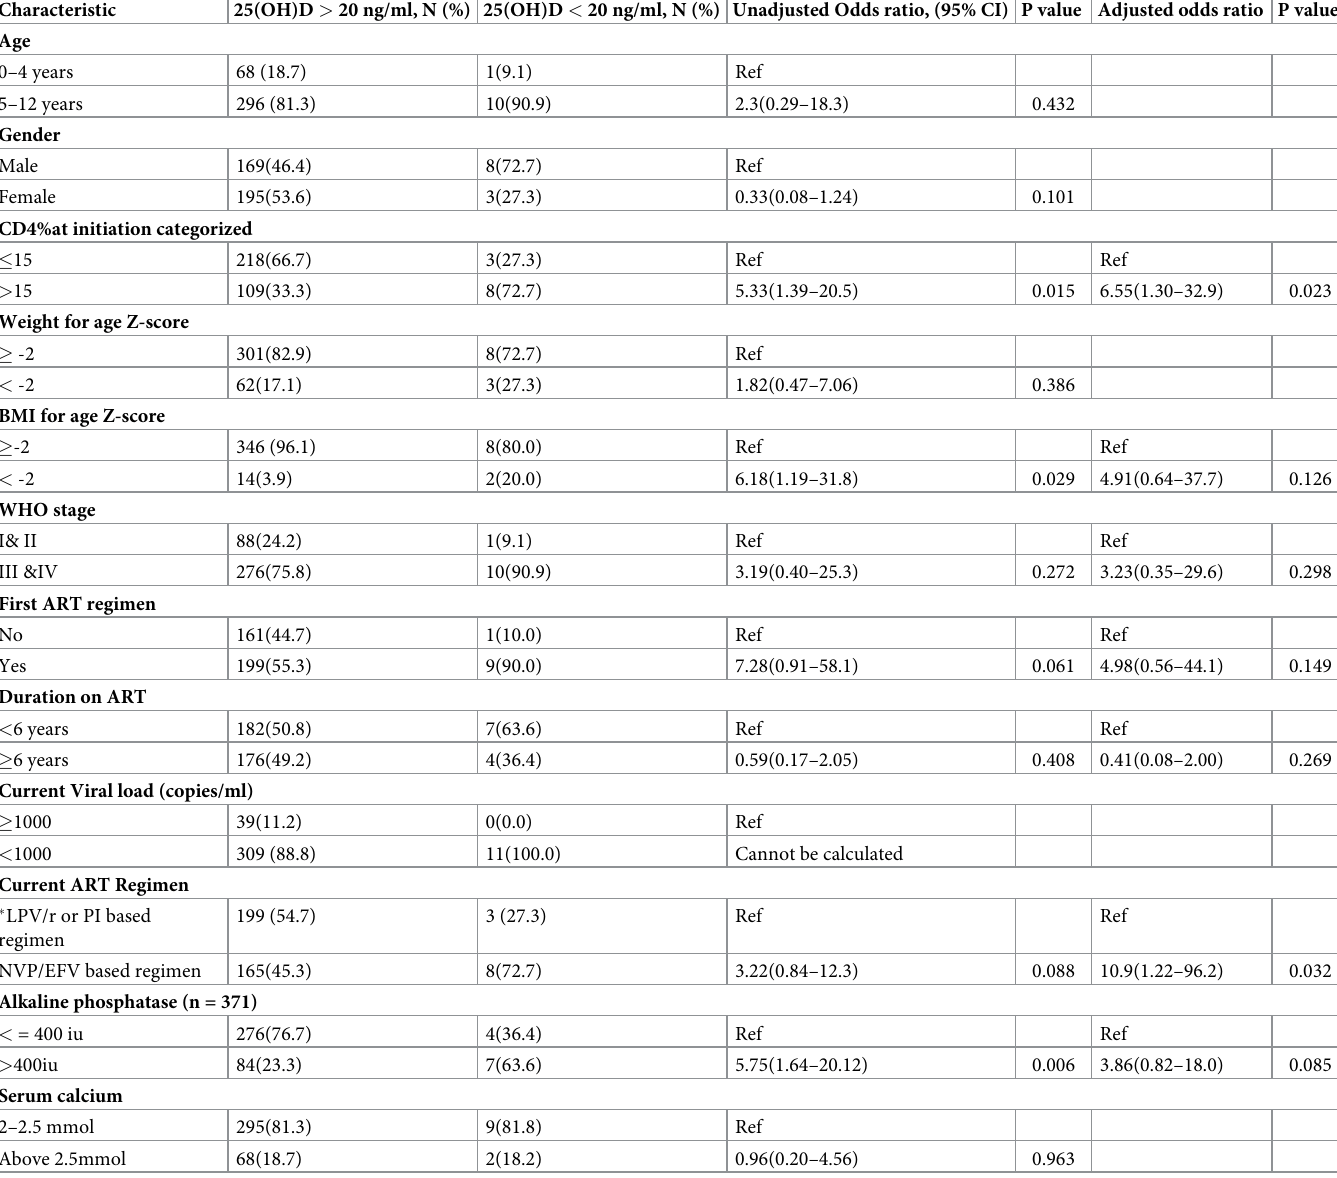
Table 3. Factors associated with serum 25(OH)D < 20 ng/ml (VDD) among HIV infected children.